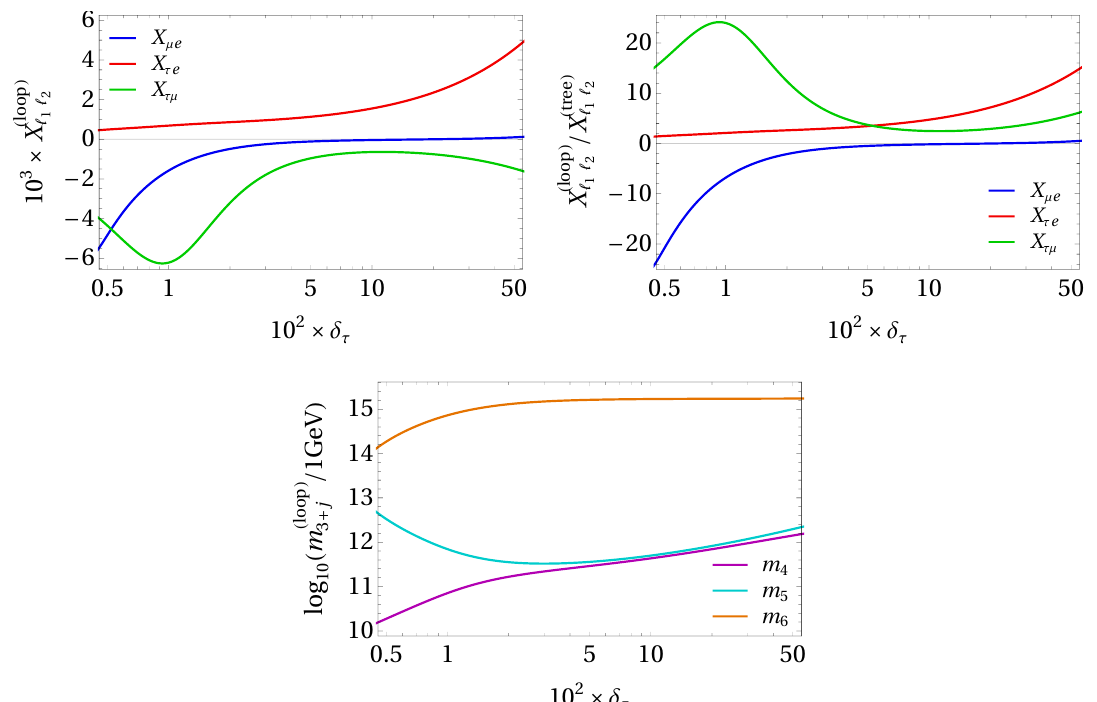
Figure 1 . X (loop) (top-left panel), X (loop) / X (tree) (top-right panel), and m (loop) ‘ 1 ‘ 2 ‘ 1 ‘ 2 ‘ 1 ‘ 2 against δ τ in a case where all other input parameters are kept fixed at values given in the main text.